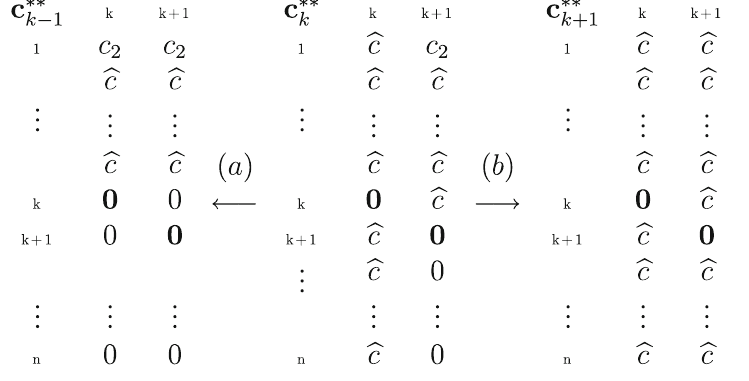
Fig. 10 Columns k and k + 1 in c ∗∗ k , c ∗∗ k −